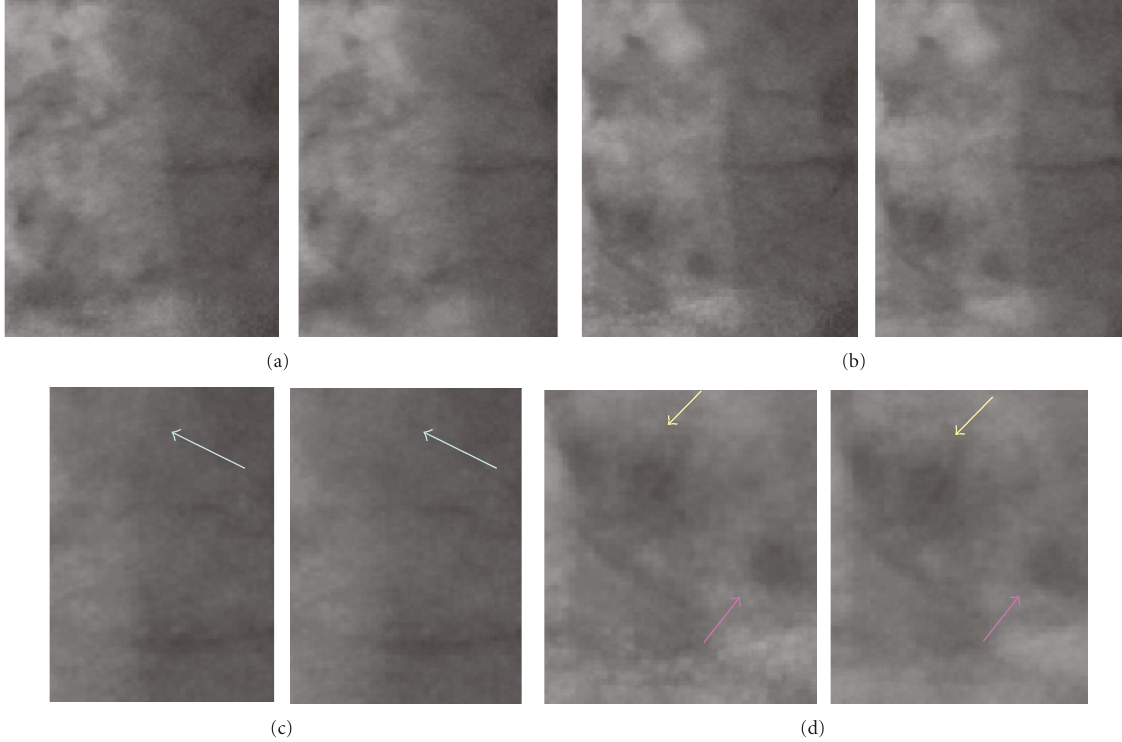
Figure 12: (a) Two time instants of a fluoroscopic sequence processed with the HR, (b) the ANMCR filter, (c), (d) one detail of each image is shown. (c) Highlights the better cardiac border contrast, and (d) the better lungs detail